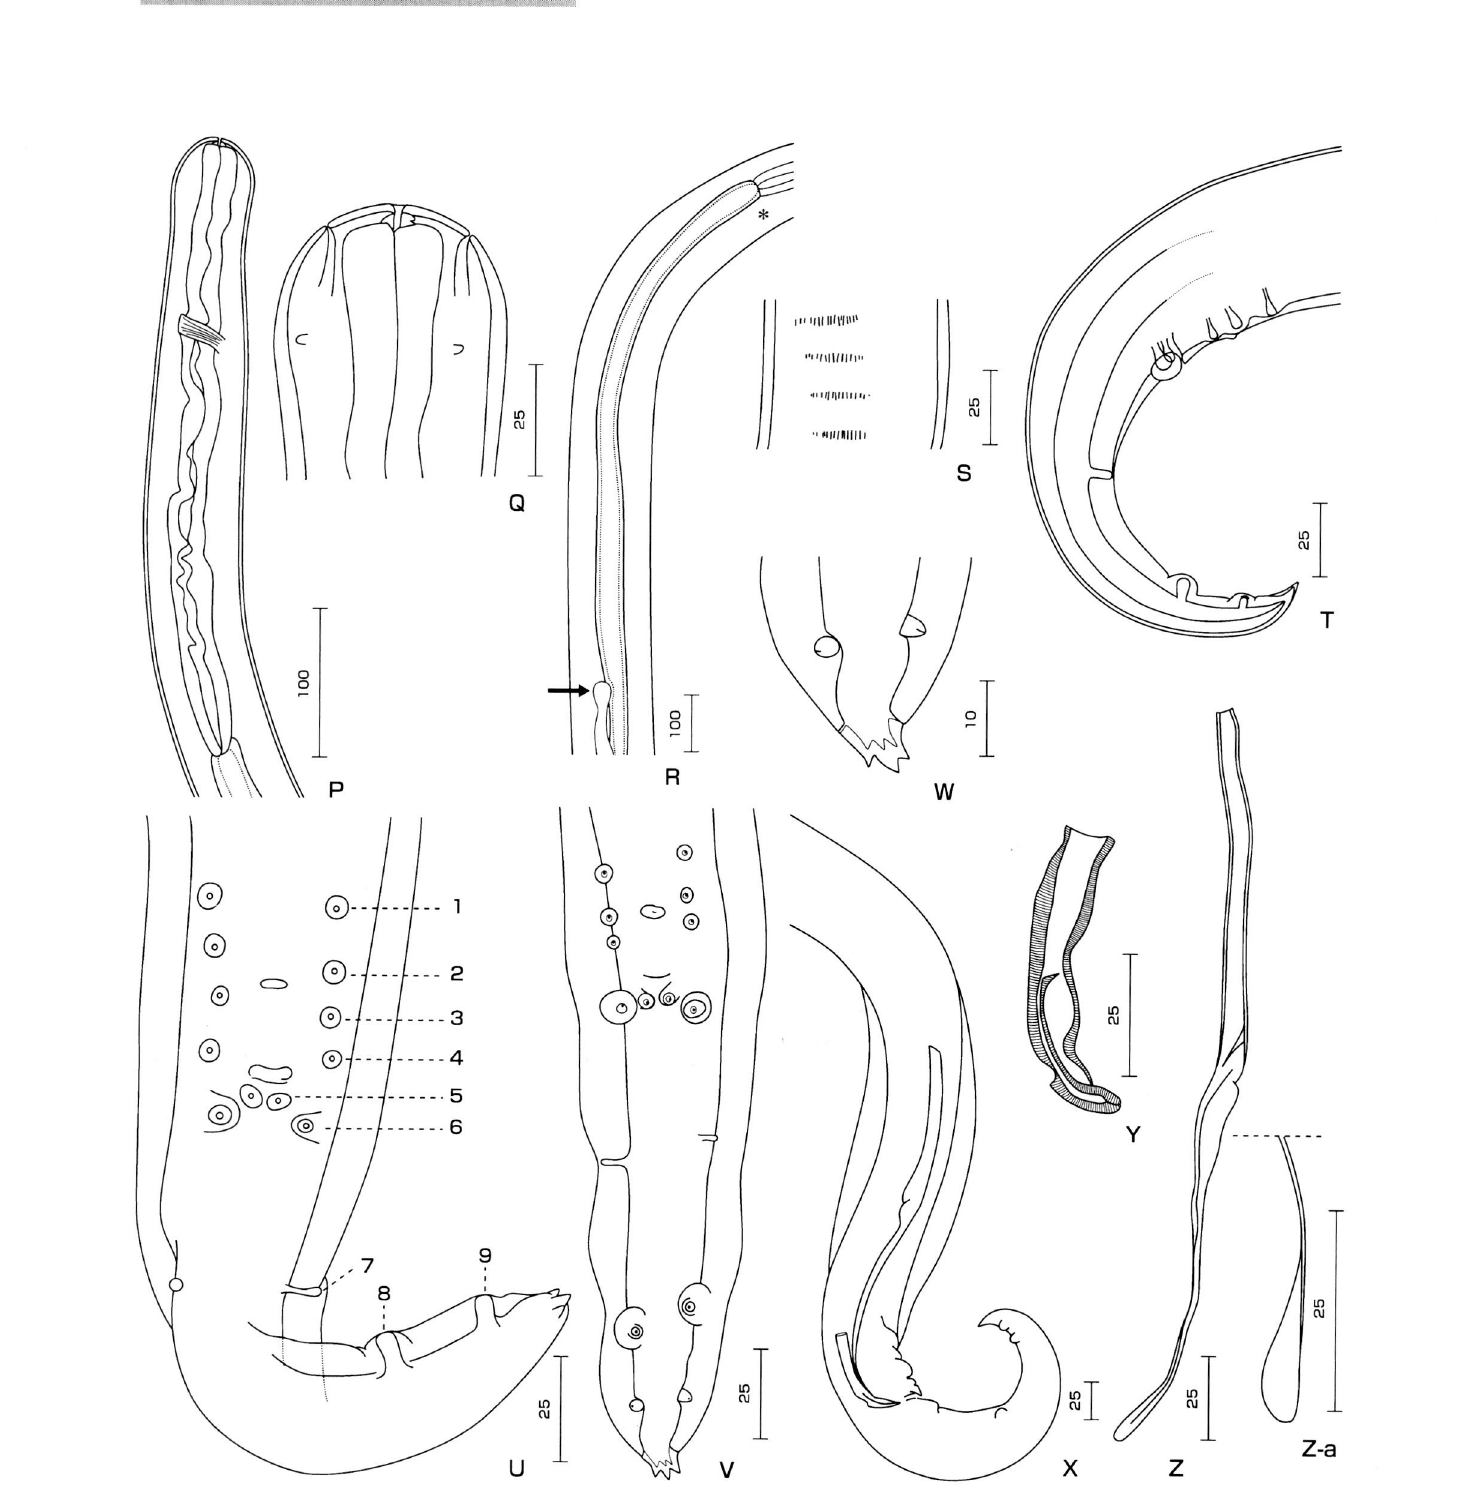
Fig. 2. - Cercopithifilaria longa n. sp. P-Z-a, males. P. Anterior part, lateral view. Q. Head, median view. R. Esophagointestinal junction (*) and position of apex of testis (arrow). S. Area rugosa, ventral view. T. Caudal part, lateral view. U. Tail of a paratype. V. Tail of ano­ ther paratype, ventral view. W. Catidal extremity, ventral view. X. Posterior part, lateral view. Y. Right spicule, lateral view. Z. Left spi­ cule, lateral view. Z-a. Left spicule, posterior end. Bars, micrometers.